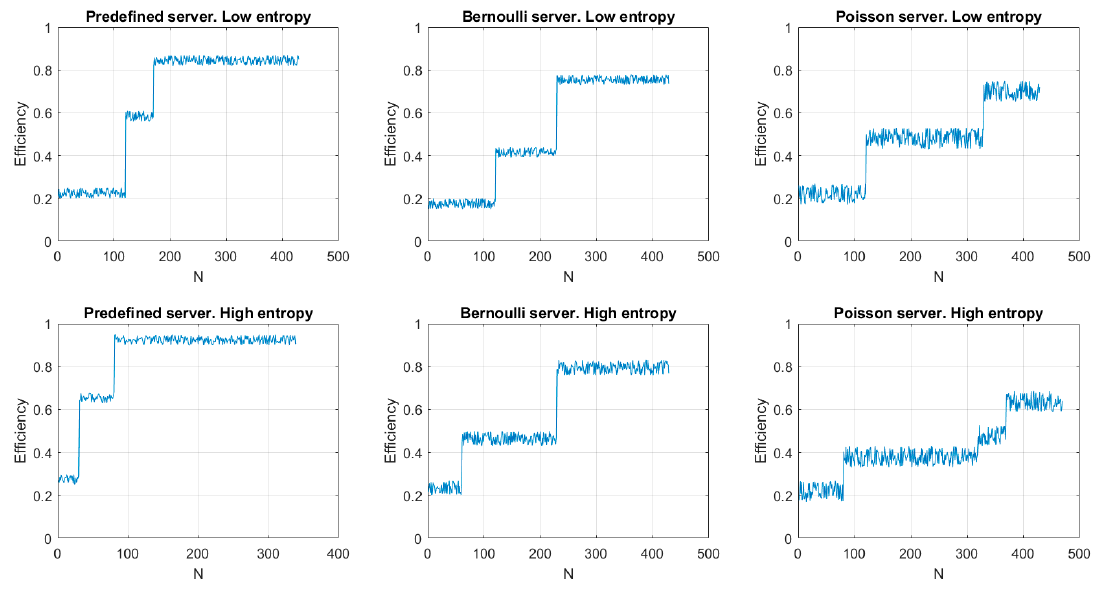
Figure 8. First experiment: results.